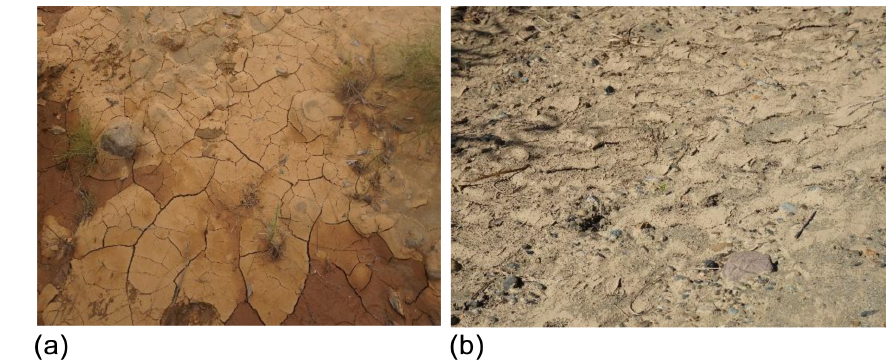
Figure 1. Photographs of river material deposited on the channel banks of a mining tributary (a) and a non-mining tributary (b) in the Thio River